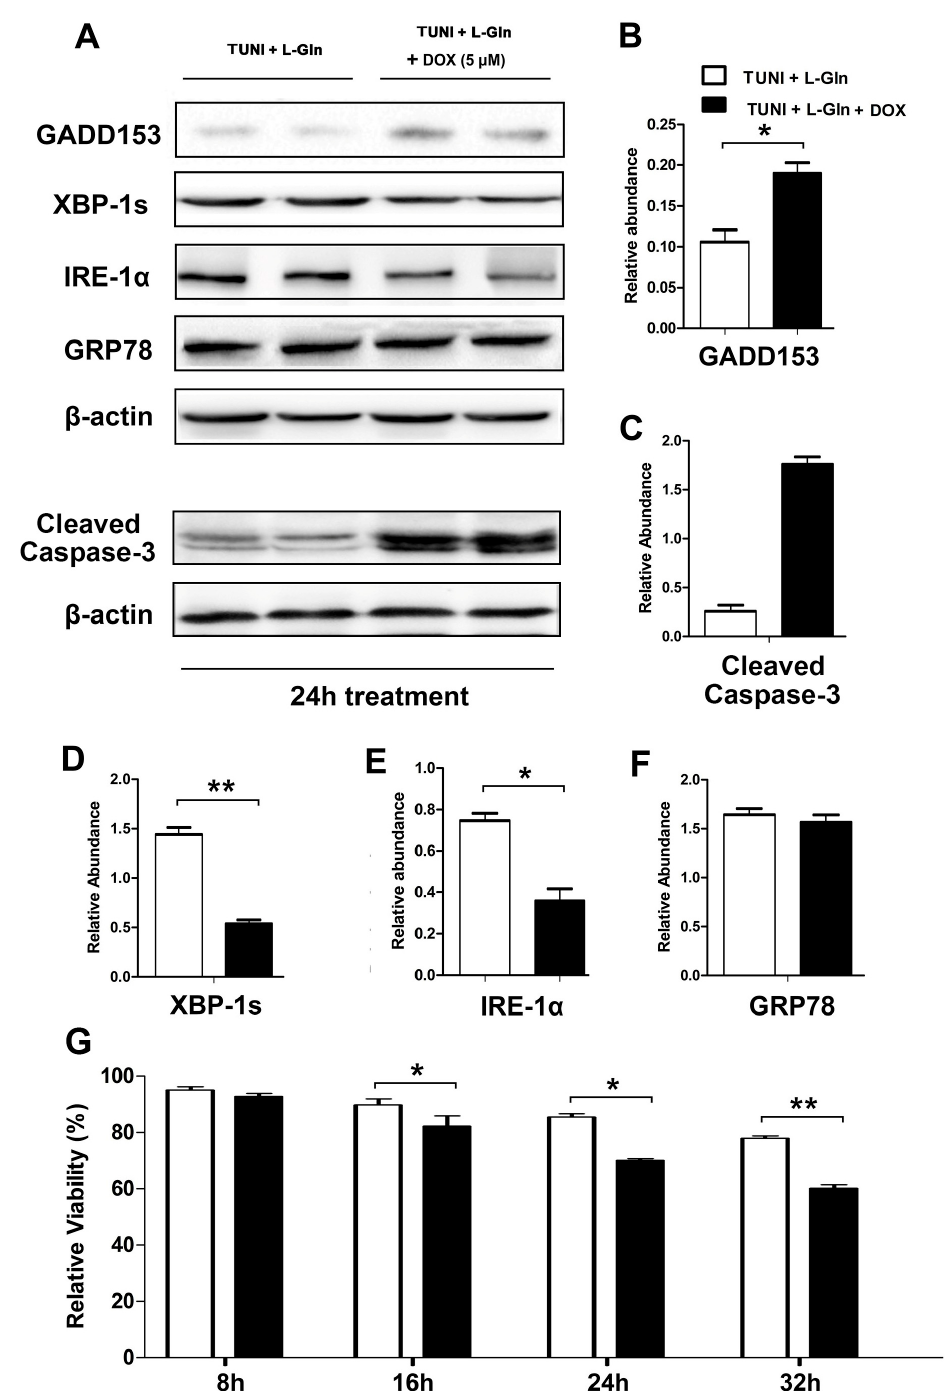
Figure 6. Inhibition of IRE-1 α and XBP-1 reverses the anti-apoptotic effect of L -glutamine. In basic DMEM, cells were treated with 1.0 µ g mL − 1 TUNI and 0.45 g L − 1 L -glutamine or a combination of TUNI, L -glutamine and 4 µ M DOX for 24 h. ( A ) Expression of GADD153, IRE-1 α , XBP-1s and GRP78 proteins was measured using the Western blot; two representative protein bands from the three independent experiments are shown; ( B ) Relative abundance of GADD153; ( C ) Relative abundance of cleaved caspase-3; ( D ) Relative abundance of XBP-1s; ( E ) Relative abundance of IRE-1 α ; ( F ) Relative abundance of GRP78; ( G ) Relative cell viability was measured using CCK-8 after treatment. β -actin was assessed as a loading control, and data are given as the means ± SDs for the three independent experiments (* means under T test, p < 0.05, ** means under T test, p < 0.01).